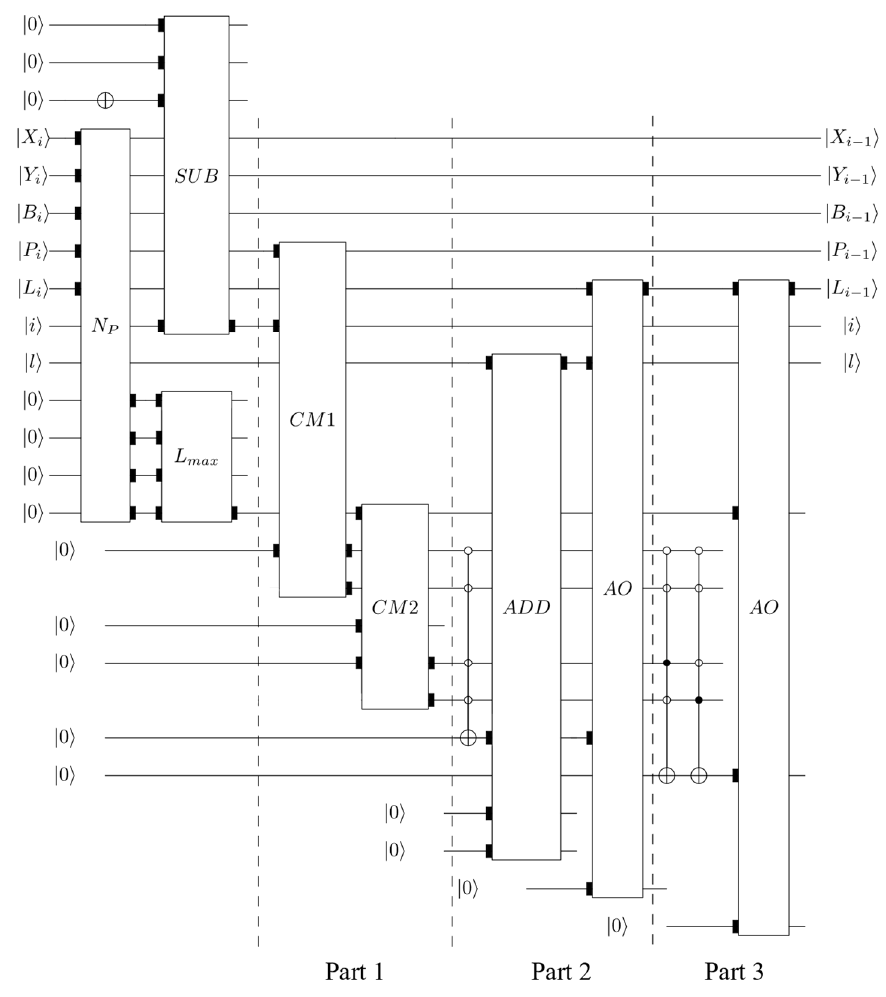
Figure 15. The quantum circuit of Equation (3).